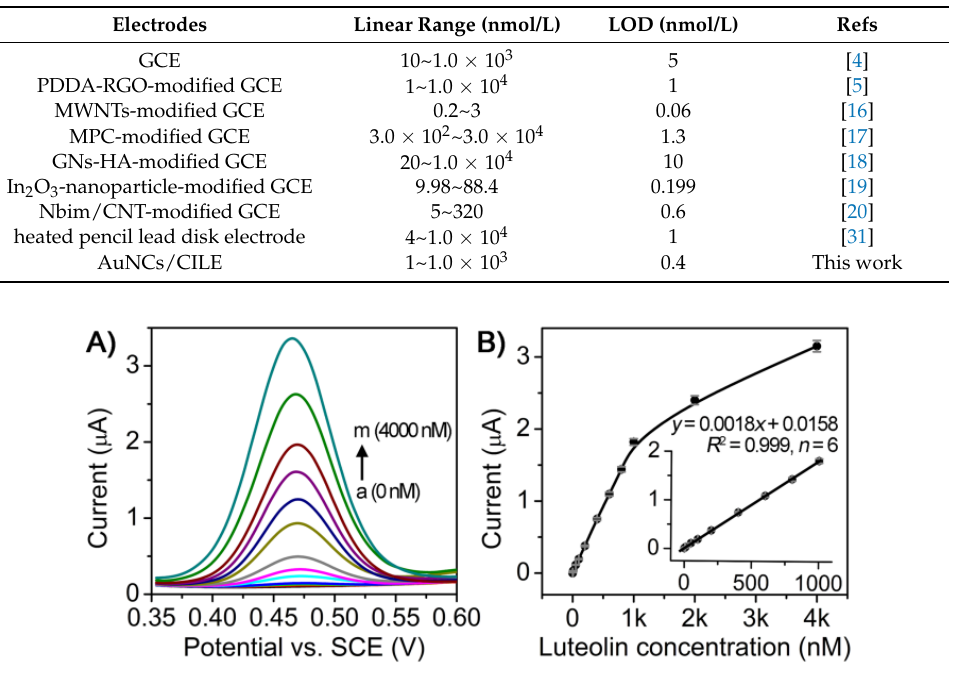
Table 1. Comparison of analytical performances of various electrochemical methods for luteolin.